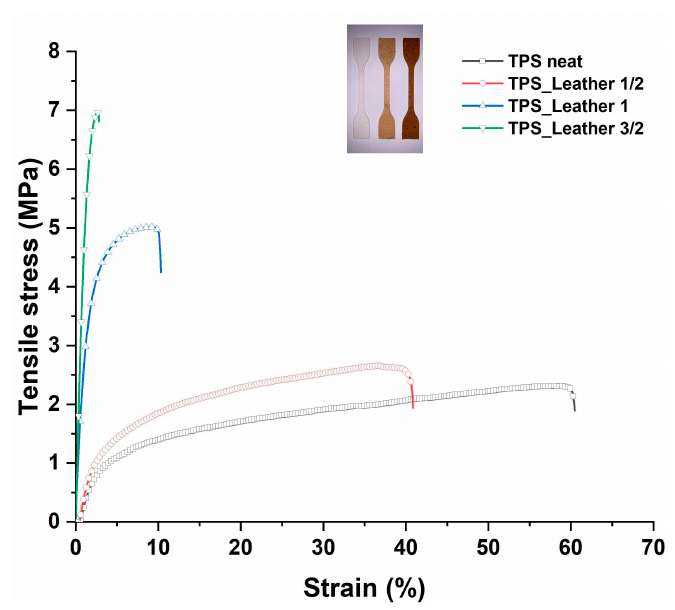
Figure 5. Typical tensile stress-strain curves.